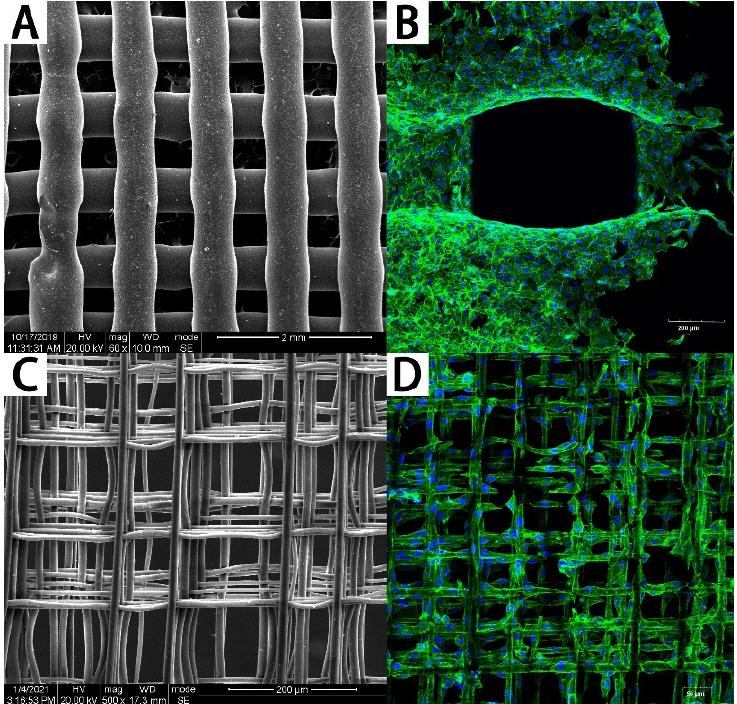
Figure 2. The PCL scaffolds fabricated by FDM and MEW. ( A ) The PCL scaffold fabricated by FDM and ( B ) cells cultured on it. ( C ) The PCL scaffold fabricated by MEW and ( D ) cells cultured on it.